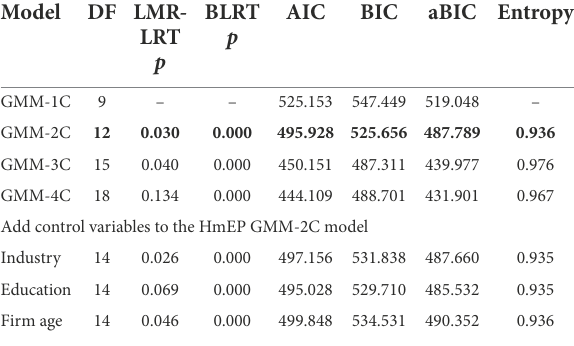
TABLE 3 Comparison of fit degree of latent variable growth models of different classifications of